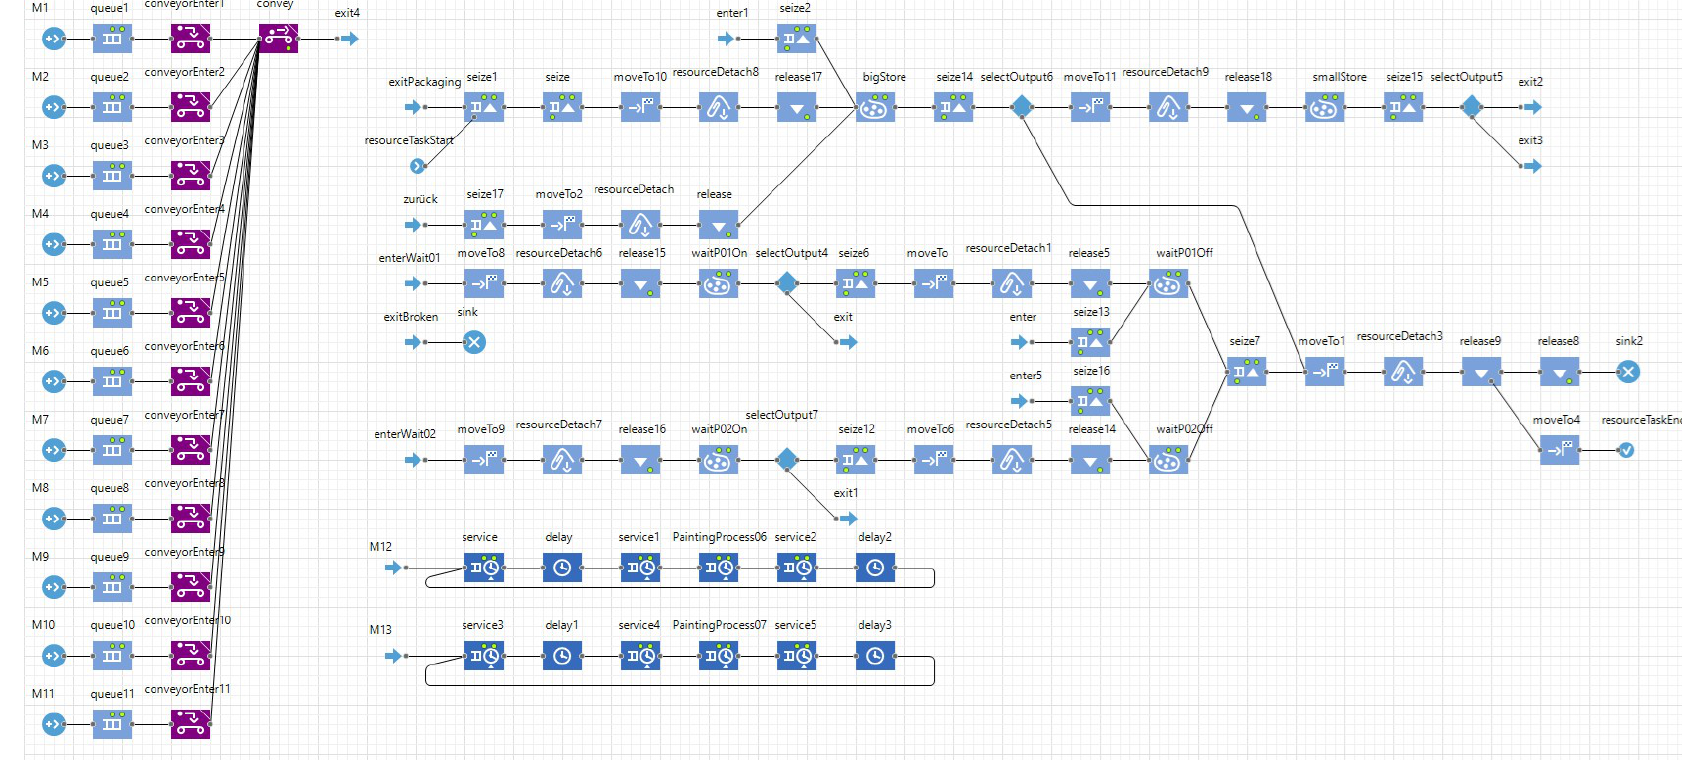
Figure 7. Structure of simulation model for the application case of the paper in AnyLogic